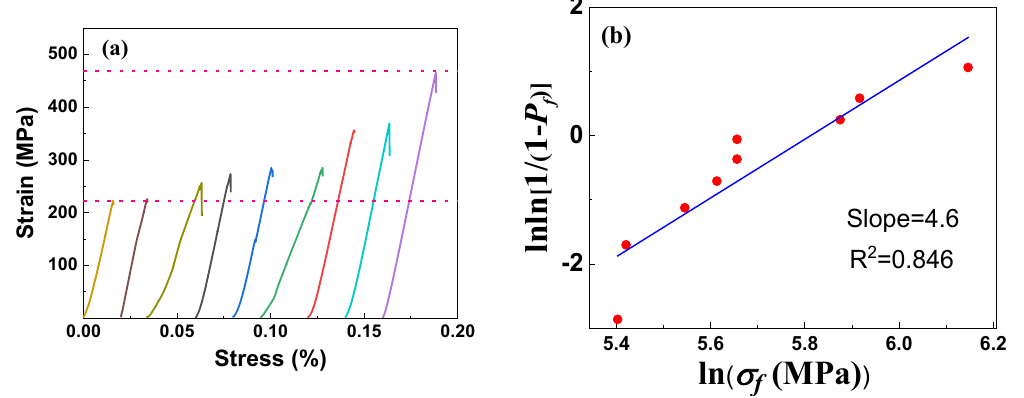
Figure 5. Compressive test results of 3D-printed Mg-based metallic glasses: ( a ) Compressive stress–strain curves from 9 samples. ( b ) Weibull plots of compressive fracture strength.